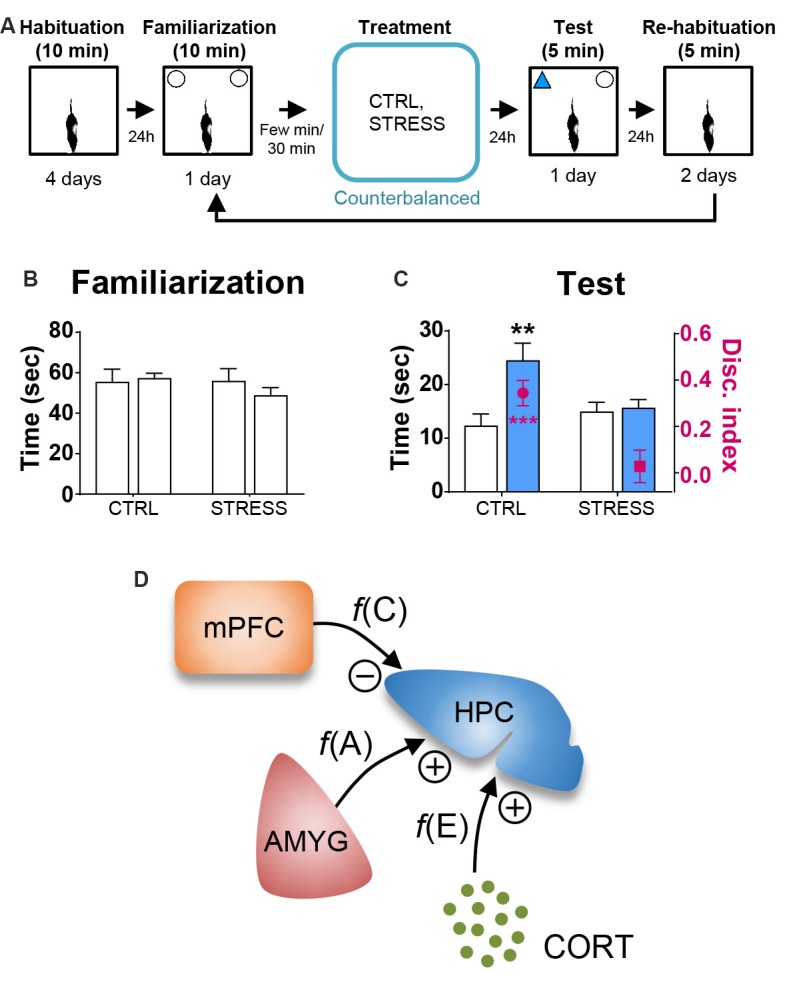
Behavioral stress effects on OR memory. (A) Behavioral procedure. (B) Mean time in seconds (± SEM) that CTRL and STRESS treatment animals spent exploring two identical objects during the familiarization phase. (C) Mean time in seconds that CTRL and STRESS treatment animals spent exploring novel vs. familiar objects and the mean value of discrimination index during the first 2 min of the test phase. **p < 0.01 and ***p < 0.001. (D) A systems-level model of stress comprising of CORT, AMYG and mPFC interaction. The model posits that the CORT, AMYG and mPFC mediate the functions of excitability f(E), aversiveness f(A), and controllability f(C), respectively, and that CORT and AMYG exert excitatory stress influences while mPFC exerts inhibitory stress influence on the hippocampus (HPC). Adapted from references Kim and Diamond (2002); Kim and Haller (2007) and Kim et al. (2015).